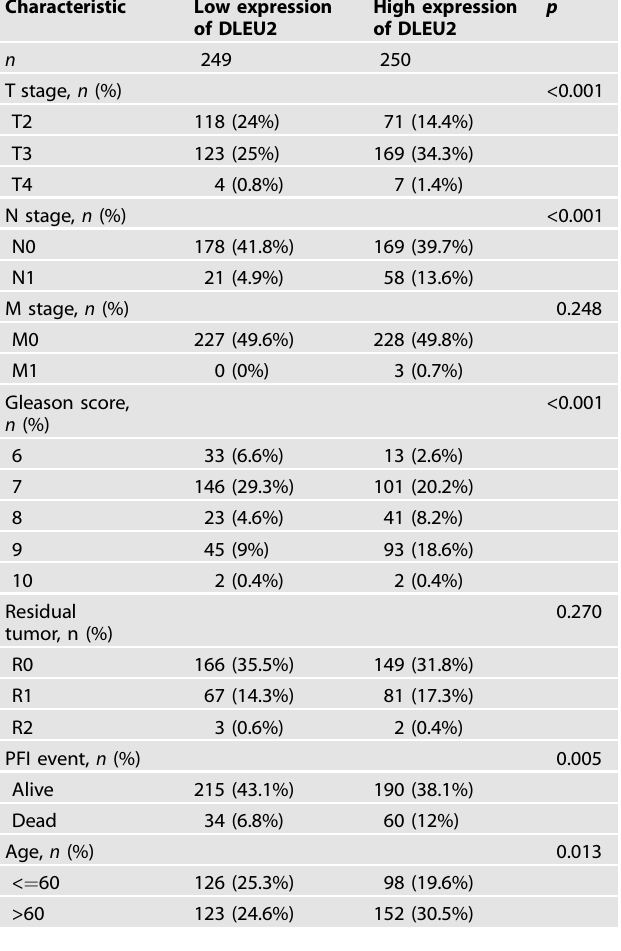
Table 1. Patients ’ information in the TCGA.